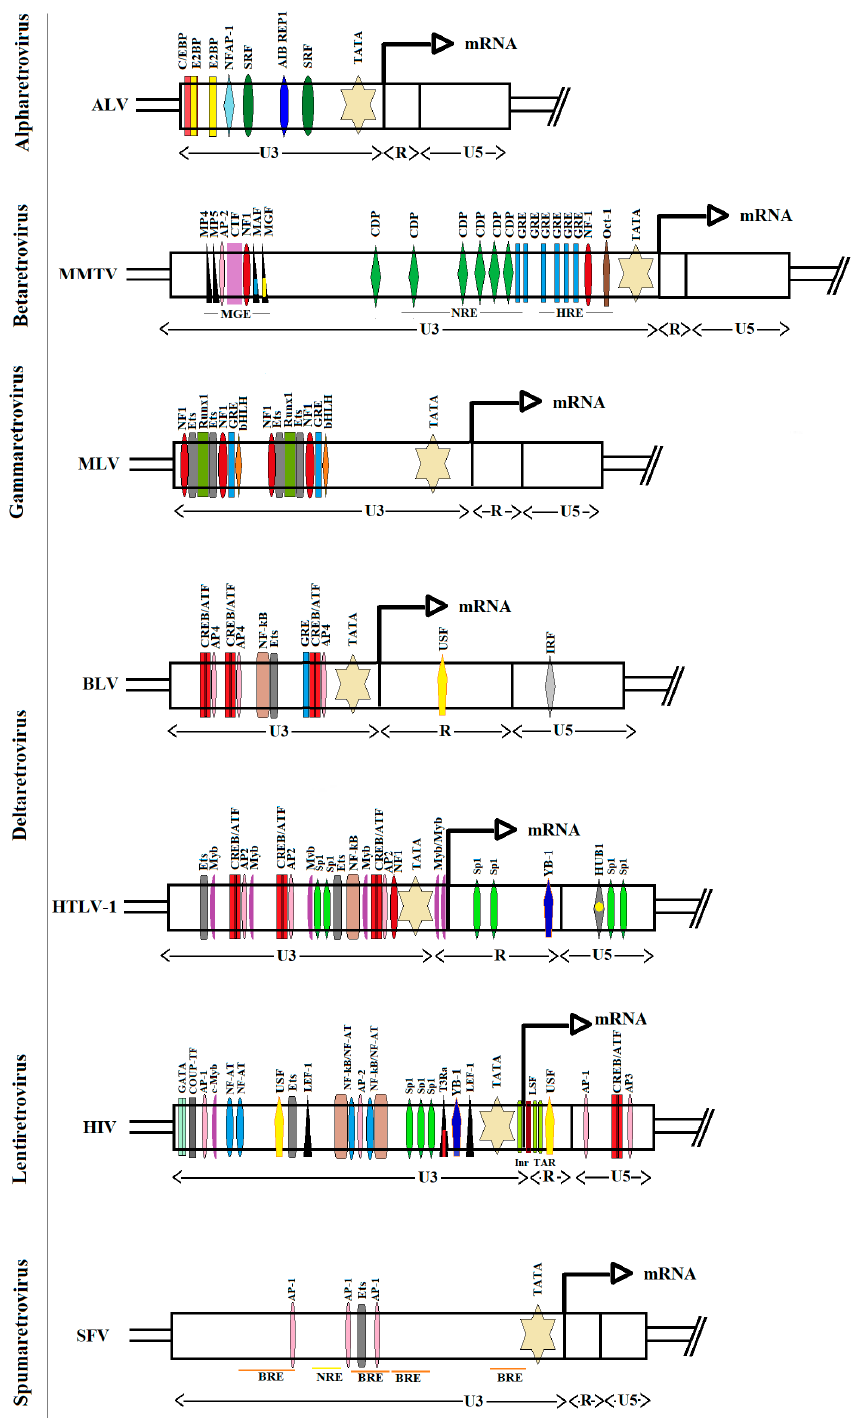
Figure 1. Comparison of the architecture of retroviral LTRs. Transcription factor binding sites identified within LTRs are shown with respect to the structural regions (U3, R, U5). Transcription factor binding sites are color-coded: C / EBP, CCAAT / enhancer binding protein in bright red; E2BP, E2 binding